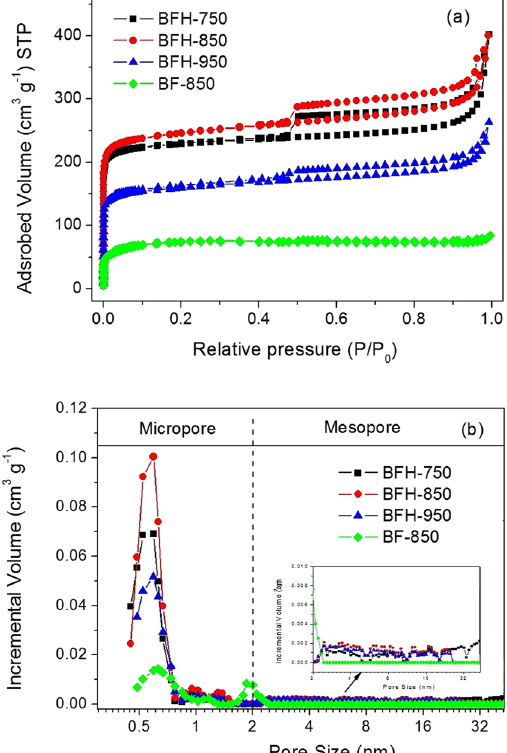
Figure 4. Nitrogen adsorption/desorption isotherm ( a ) and pore size distribution ( b ) of BF-850, BFH-750, BFH-850 and